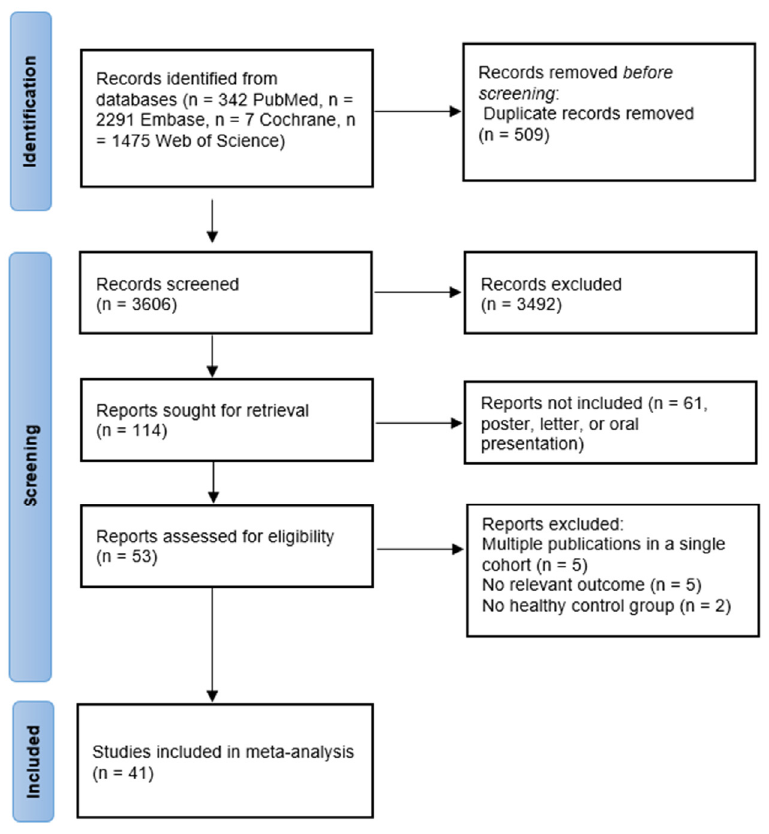
Figure 1. PRISMA flow diagram for identification of studies for meta-analysis. PRISMA, Preferred Reporting Items for Systematic reviews and Meta-Analyses.